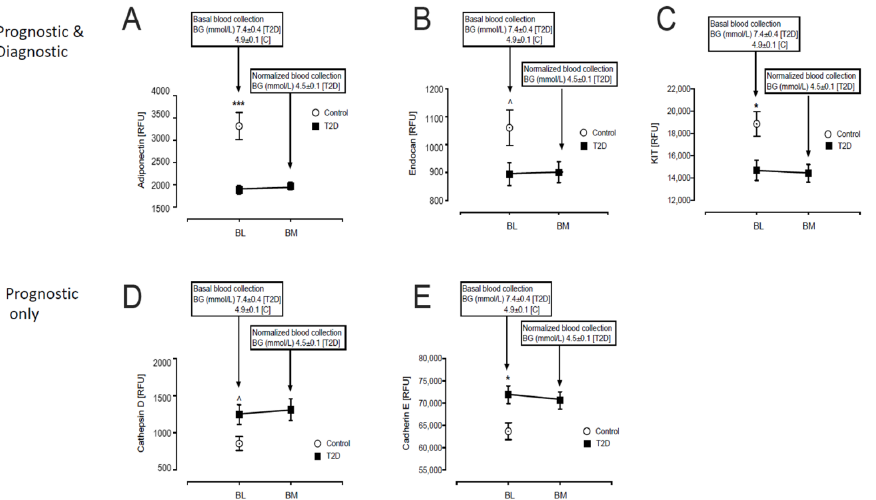
Figure 1. Comparison of the prognostic and diagnostic proteins of β -cell dysfunction in plasma at BL and post-iatrogenic induction of euglycemia (BM) in T2D subjects. Blood sampling for proteomics was performed at baseline (BL) in controls (white circles) and T2D (black squares) and again at euglycemia (BM) for the T2D subjects. Proteomic (Somalogic) analysis of prognostic and diagnos- tic proteins of β -cell dysfunction was undertaken for Adiponectin ( A ), Endocan ( B ), Mast/stem cell growth factor receptor-Kit (KIT) ( C ), Cathepsin-D ( D ), Cadherin-E ( E ). ^ p < 0.05; * p < 0.01; *** p < 0.0001. BG, blood glucose; RFU, relative fluorescent units; T2D, type 2 diabetes. Of the 16 diagnostic only proteins, 4 were higher in T2D: Kallikrein-4 (214 ± 9 vs. 181 ± 3, T2D vs. control, p = 0.001), Aminoacylase-1 (4616 ± 514 vs. 2956 ± 346 RFU, T2D vs. control, p = 0.001), Insulin-like growth factor-binding protein-4 (IGFBP4) (7334 ± 212 vs. 6658 ± 255 RFU, T2D vs. control, p < 0.05) and Reticulon-4 receptor (RTN4R) (1872 ± 93 vs. 1474 ± 53, T2D vs. control, p < 0.001) (Figure 2A – D). Protein levels were unchanged from baseline in response to glucose normalization in T2D (Figures 1 and 2).